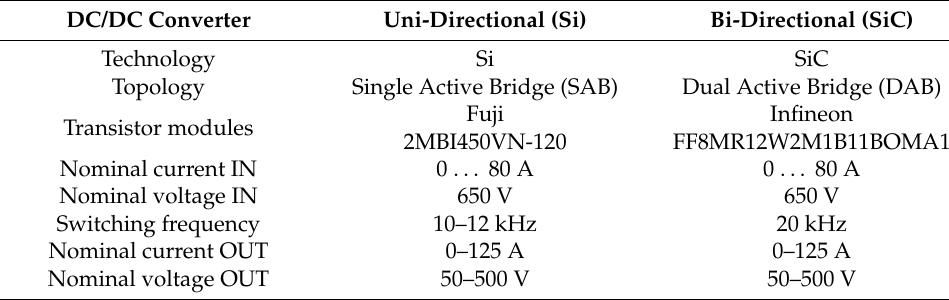
Table 5. Parameters of the DC/DC converter used in the analyzed EV